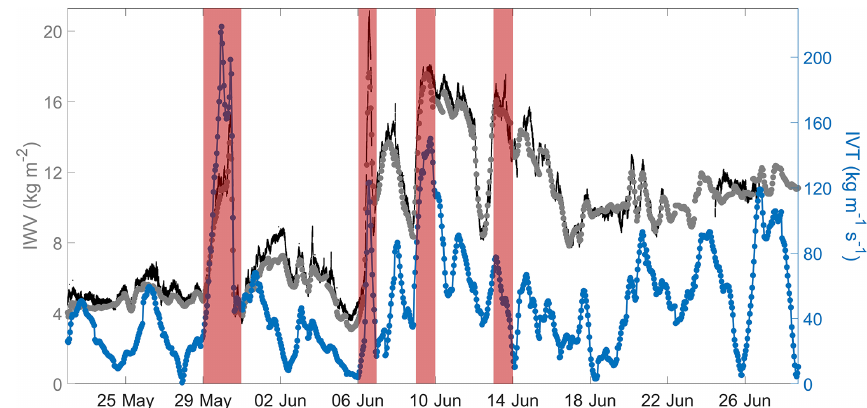
Figure 1. Time series of integrated water vapour (IWV, kgm − 2 ), based on HATPRO measurements at Ny-Ålesund (black line) and ERA5 reanalysis at the closest grid (grey dots), and integrated vapour transport (IVT, kgm − 1 s − 1 , blue dotted line), based on ERA5 reanalysis, for the ACLOUD and PASCAL campaigns (22 May–28 June 2017). Red bars show anomalous IWV and/or IVT at